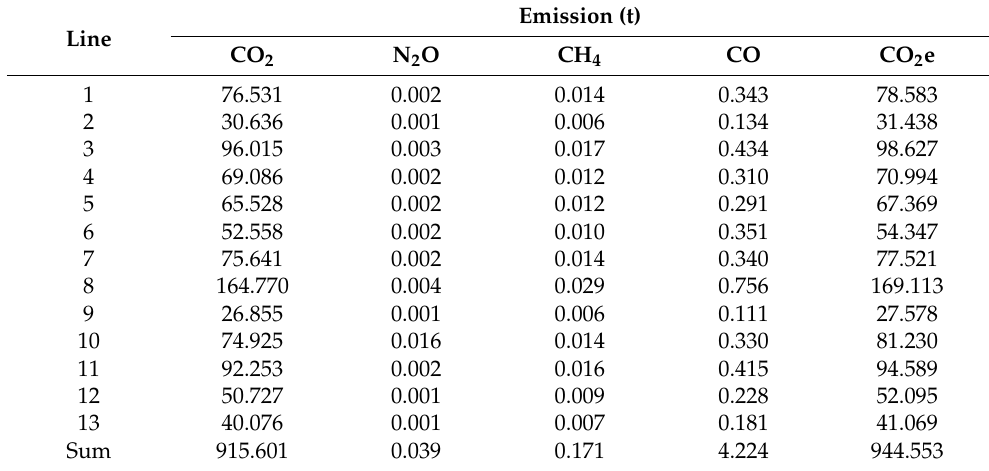
Table 5. Greenhouse gas emission calculation results for the old fleet of buses in variant V0.